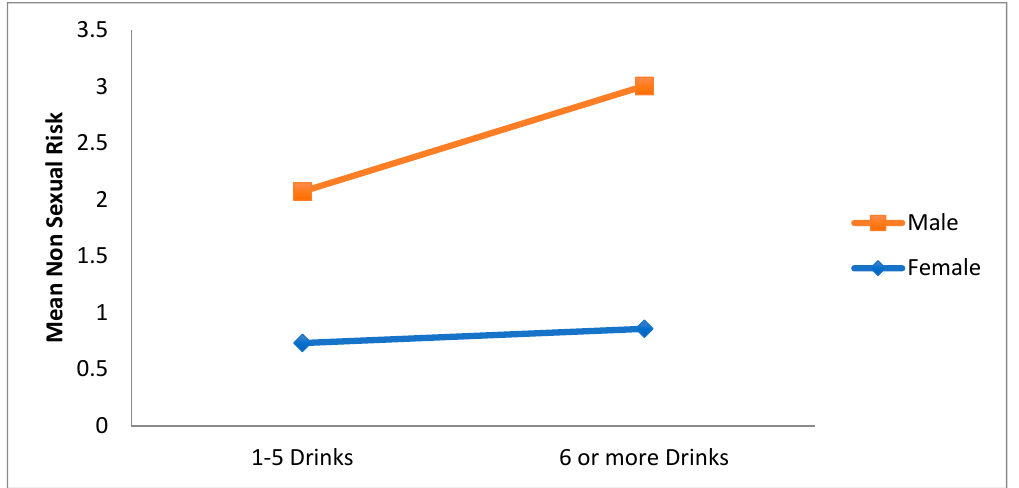
Figure 6. Interaction effect of gender on the relationship between intensity of ED use and non-sexual risk.